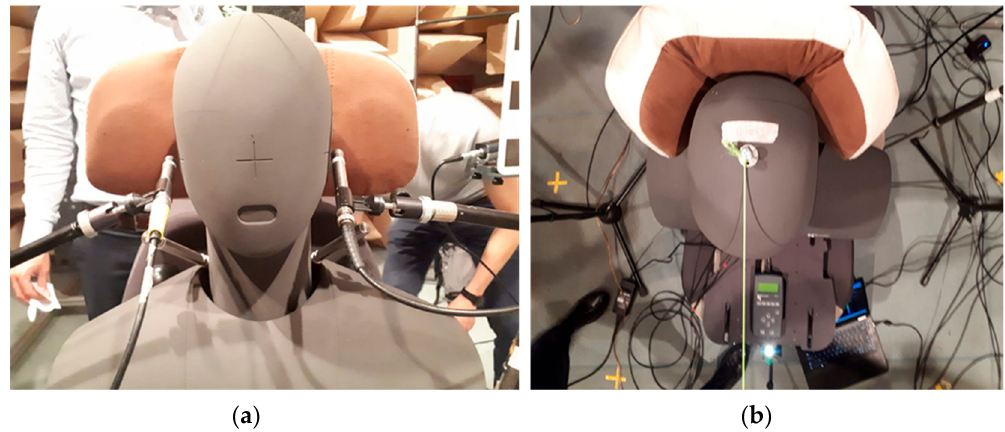
Figure 4. Different headrest geometries considered for the experimental investigations: ( a ) unfolded and ( b ) folded.